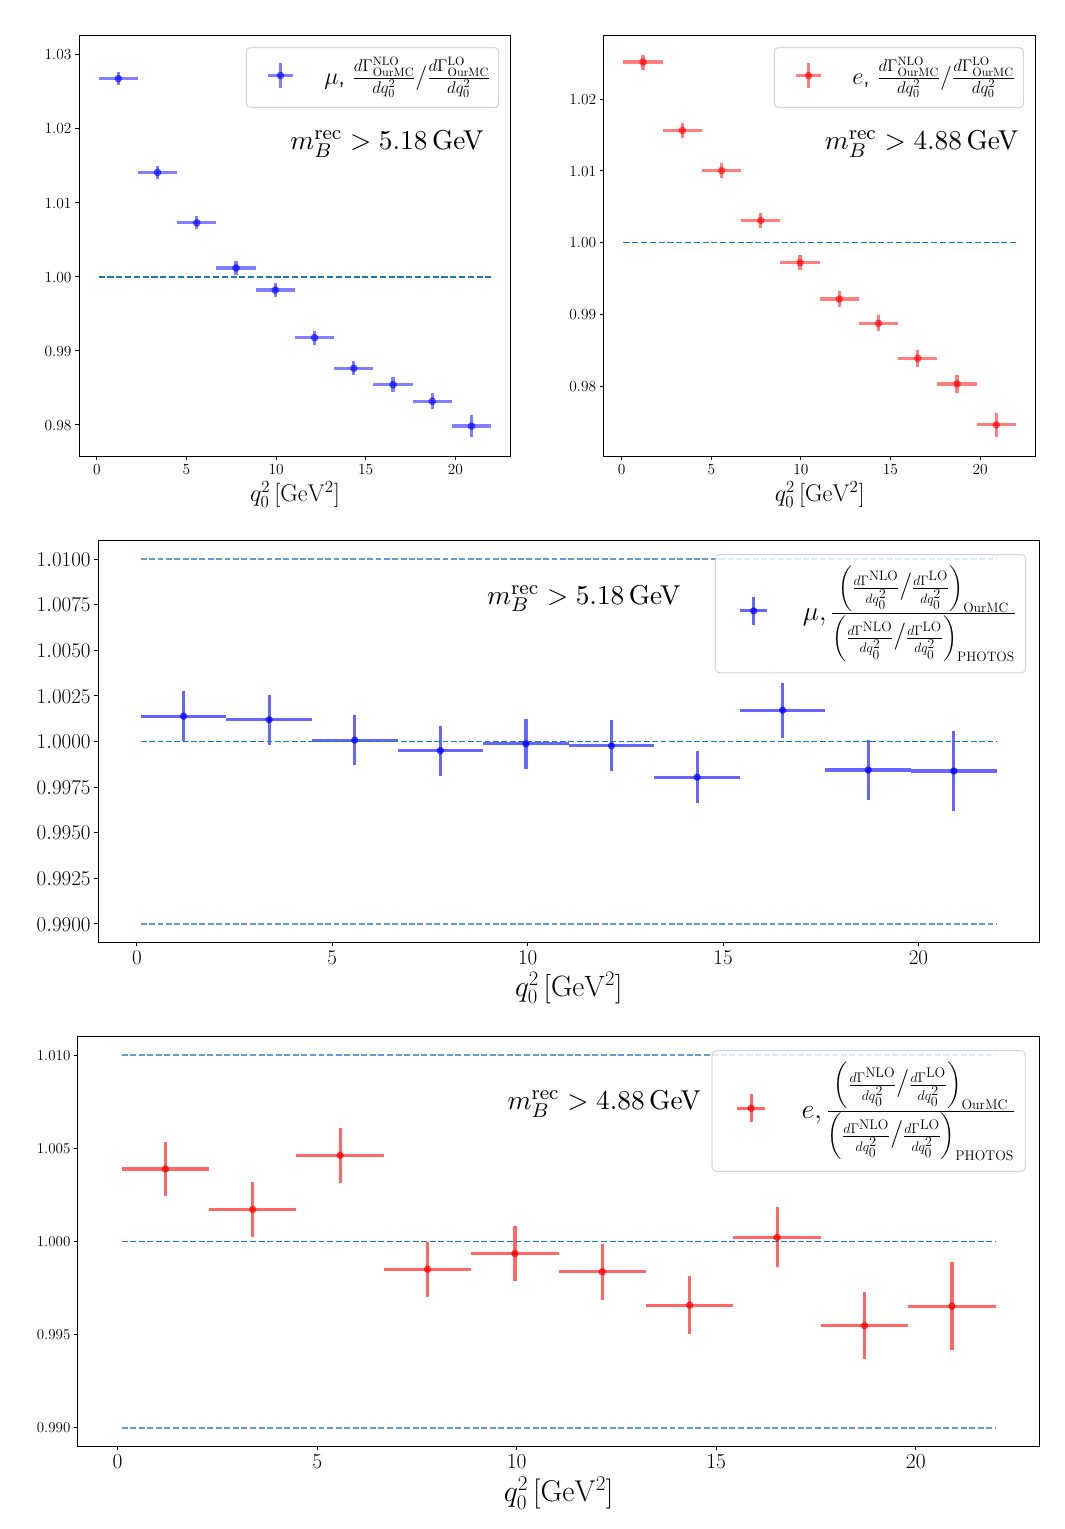
for the short distance transition only: NLO over LO for Figure 1 . Differential distributions in q 2 0 muons in blue (top left) and for electrons in red (top right) in our MC, with appropriate cuts as in table 1. The normalisation of these upper plots is arbitrary (cf. main text). The double ratios of our MC versus the PHOTOS framework, shown in the middle and bottom plots, are free of ambiguities.